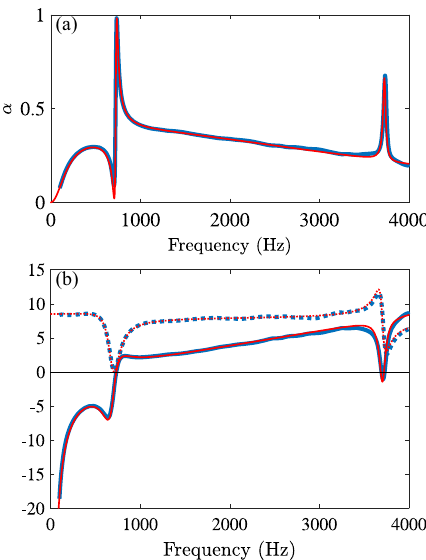
Figure 9. (a) Absorption coef fi cient and (b) impedance as functions of the frequency. The resistance are displayed by dashed lines and the reactance by solid lines. The experimental results (blue curves) are compared to the analytical results computed with the bi-articulated plate model (red